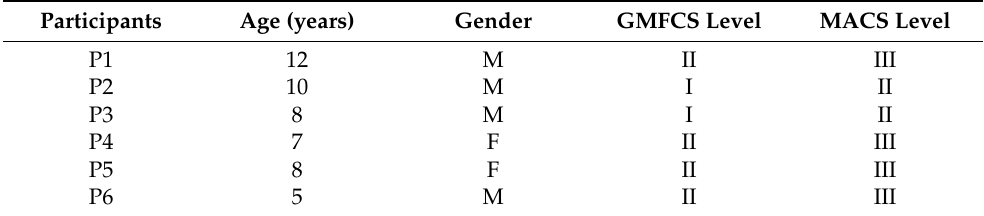
Table 1. Demographic and clinical characteristics: Gross Motor Function Classification System (GMFCS) and Manual Ability Classification System